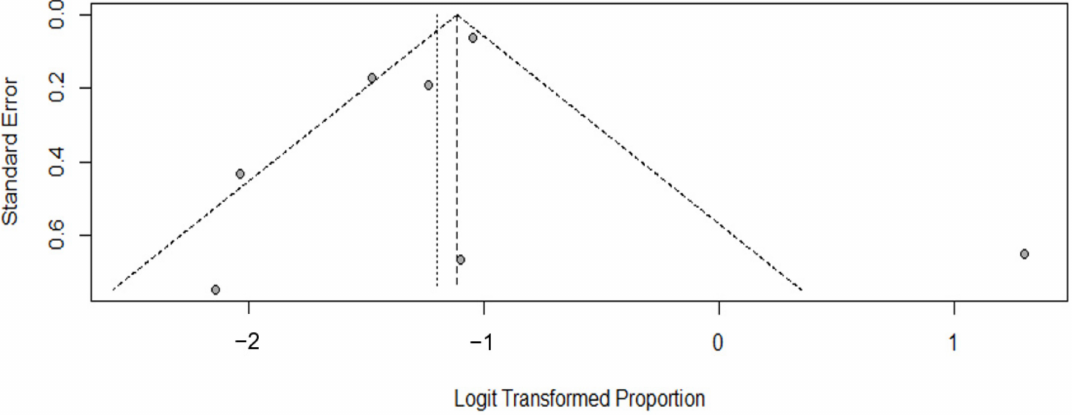
Figure 3. Search for publication bias, funnel graph. Logit transformed proportion represents the odds